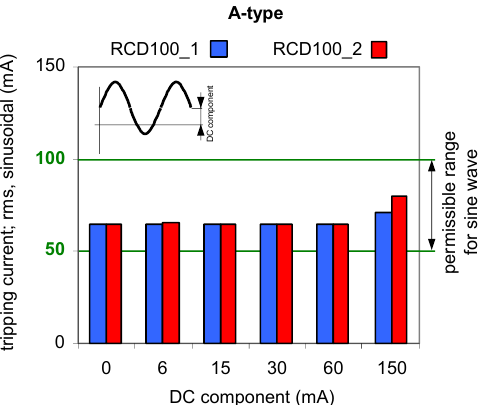
Figure 6. Tripping current (rms value of the AC sinusoidal component) of 30 mA RCDs under AC sinusoidal current superimposed by smooth DC component of values 6, 15, 30, 60, and 150 mA: ( a )